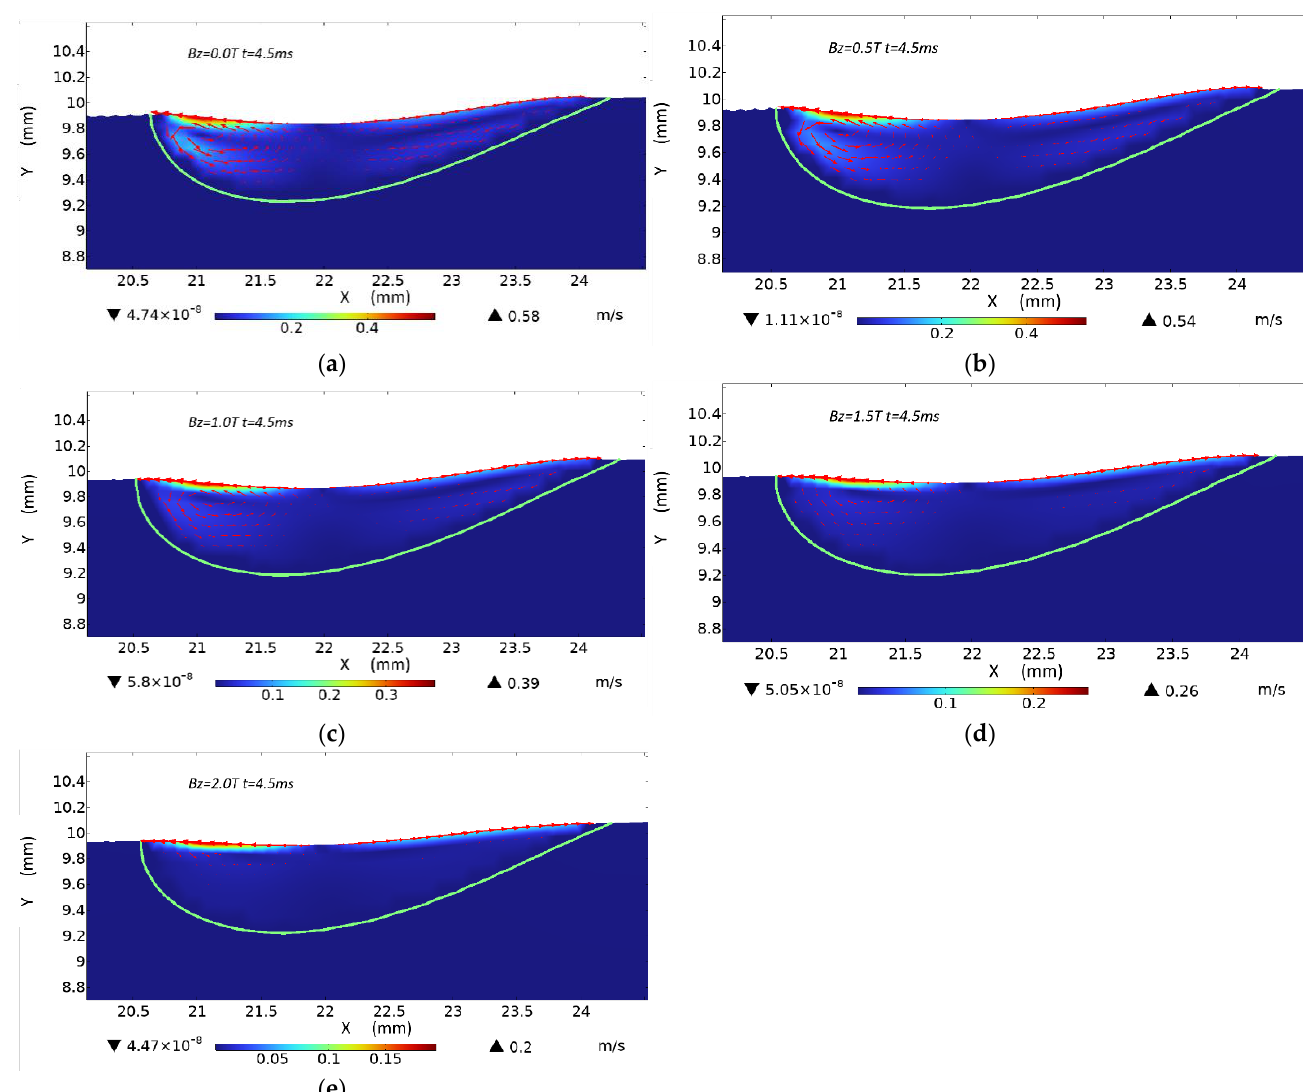
Figure 5. Distribution of flow field at different magnetic field strengths (t = 4.5 s). ( a ) Bz = 0 T; ( b ) Bz = 0.5 T; ( c ) Bz = 1 T; ( d ) Bz = 1.5 T; and ( e ) Bz = 2 T.